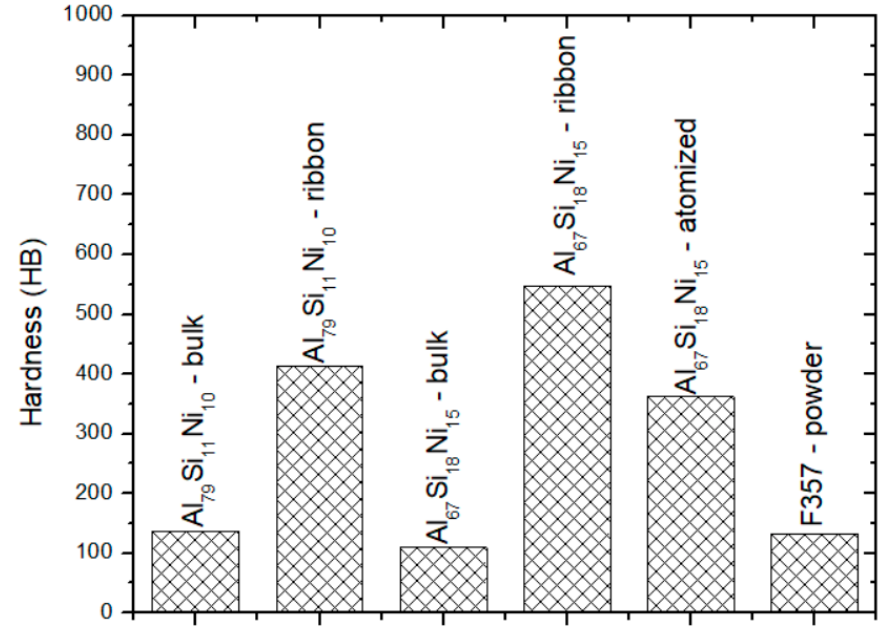
Figure 11. Brinell hardness (converted) for the bulk, melt-spun, and atomized Al 79 Si 11 Ni 10 and Al 67 Si 18 Ni 15 alloys, and the F357 (AlSi10Mg) alloy. A hardening effect due to the fast cooling techniques is noticed.